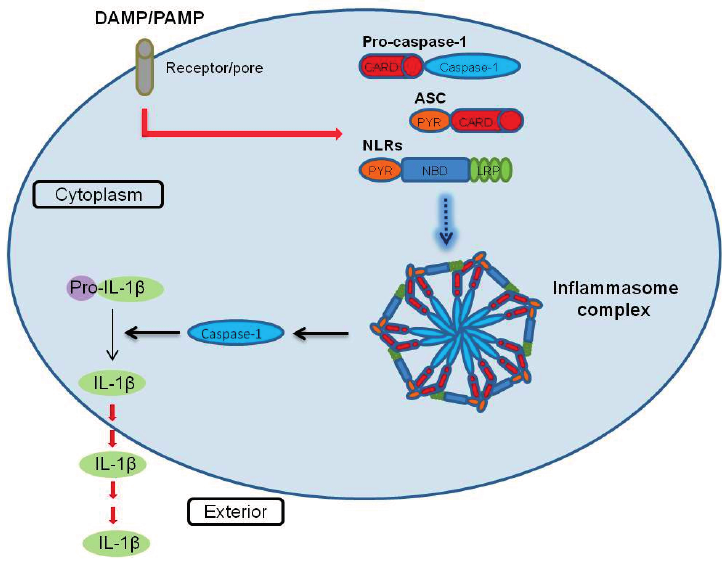
Figure 2. Schematic representation of the inflammasome activation model.